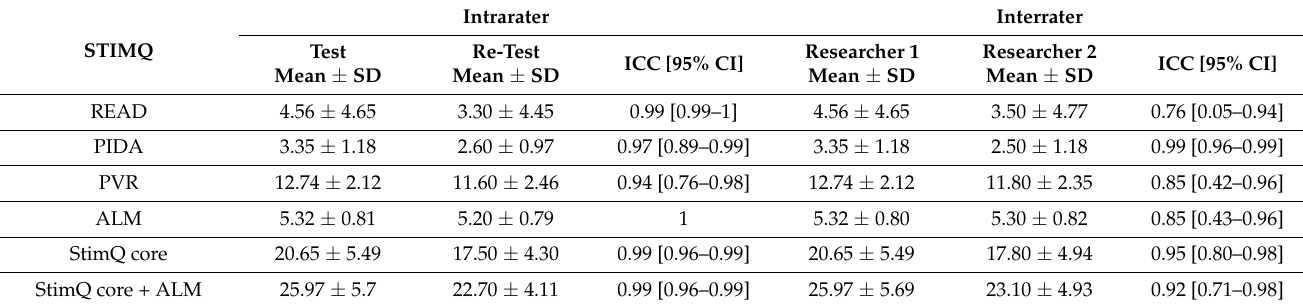
Table 5. Interrater and intrarater reliability scores for infants.